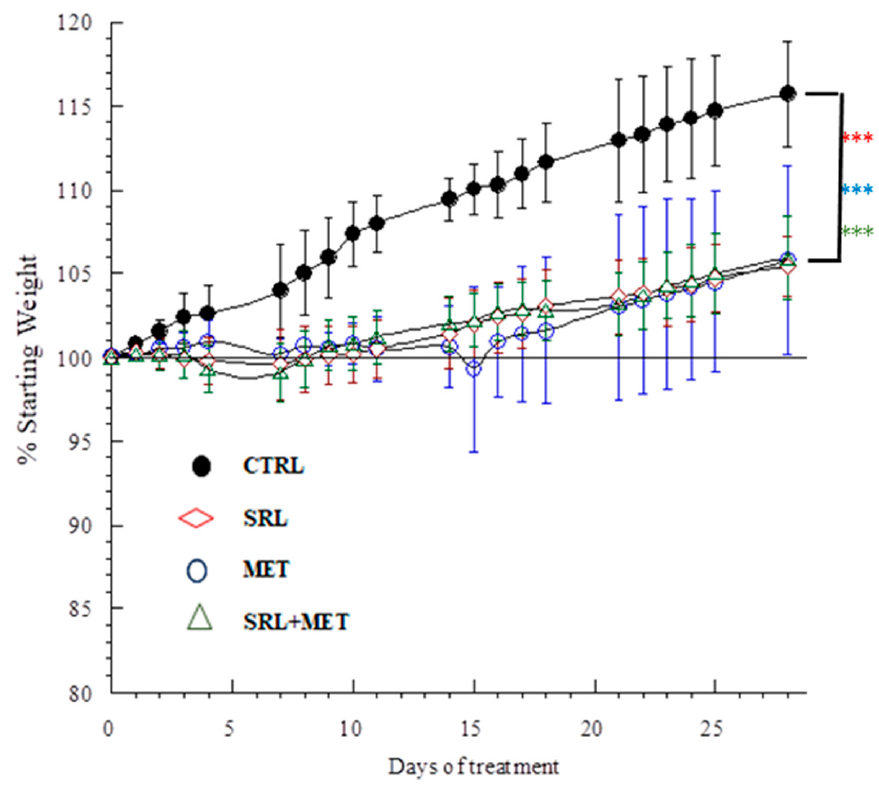
Figure 1. Weight changes in mice treated with H 2 O (control, CTRL), 5 µ g/g SRL alone (SRL),